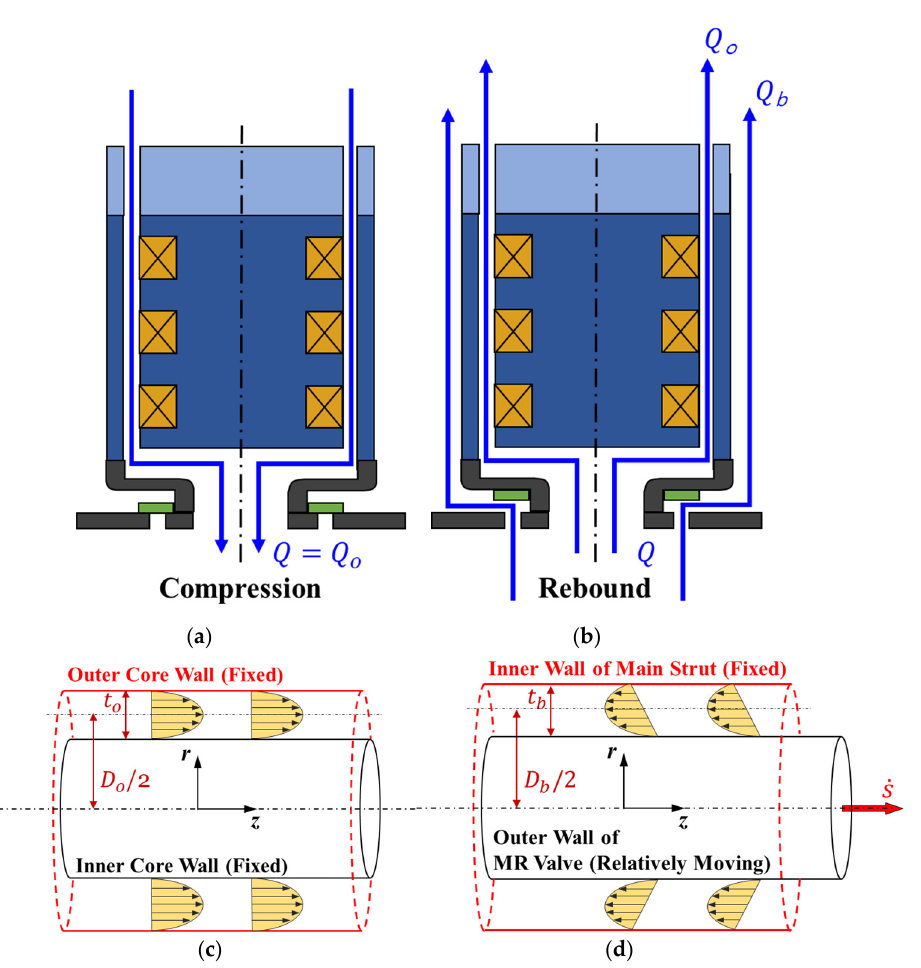
Figure 4. Fluid flow in compression and rebound conditions: ( a ) flow path in compression, valve closed; ( b ) flow path in rebound, valve open; ( c ) fluid velocity profile of the orifice: annular Poiseuille flow (APF); ( d ) fluid velocity profile of the bypass: annular Poiseuille–Couette flow (APCF).